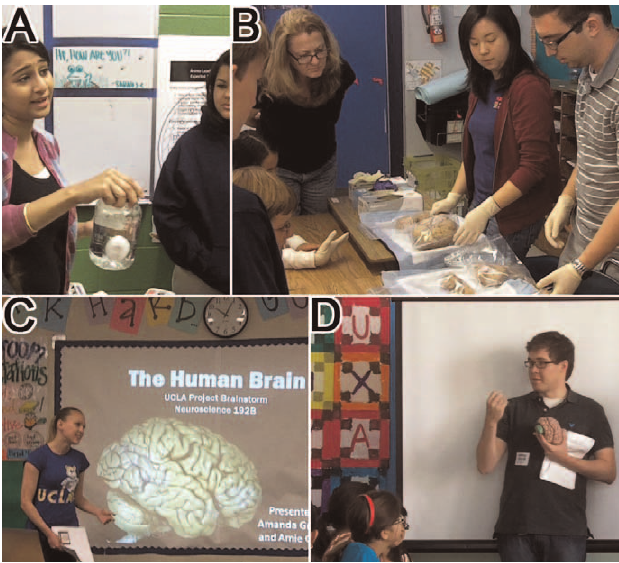
Figure 1. UCLA neuroscience undergraduate students teaching local school children about the brain. (A) Explaining how the water in a jar protects an egg from breaking in much the same way that the cerebrospinal fluid protects the brain from damage. (B) School children look at healthy and diseased human brains wrapped in plastic. (C) Undergraduate neuroscience student introduces the brain to a classroom of seventh grade students. (D) Classroom of fifth grade students learn the gross anatomy of the brain from an undergraduate student holding a model human brain. All participants in this study (legal guardians of school children, undergraduate and graduate students) provided signed consent to publication of their likeness as part of this project.